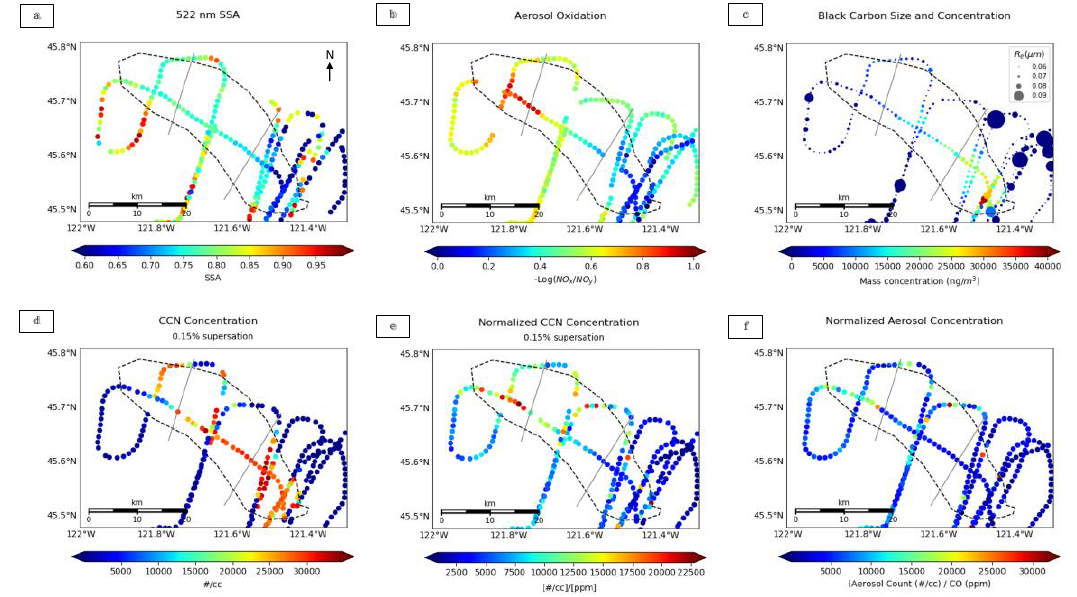
Figure 2. BBOP aircraft observations of the Government Flats Complex fire on 21 August 2013: (a) 522-nm SSA (particle soot absorption photometer (PSAP)/neph); (b) aerosol oxidation (derived from the three-channel Oxides of Nitrogen Analyzer); (c) mass concentration of black carbon (BC) and size of BC-containing particles (single-particle soot photometer (SP2)); (d) concentration of particles that can act as cloud-condensation nuclei (CCN) at 0.15% supersaturation (CCN-200 instrument); (e) the CCN concentration divided by the CO concentration; (f) the total aerosol concentration divided by the CO concentration.